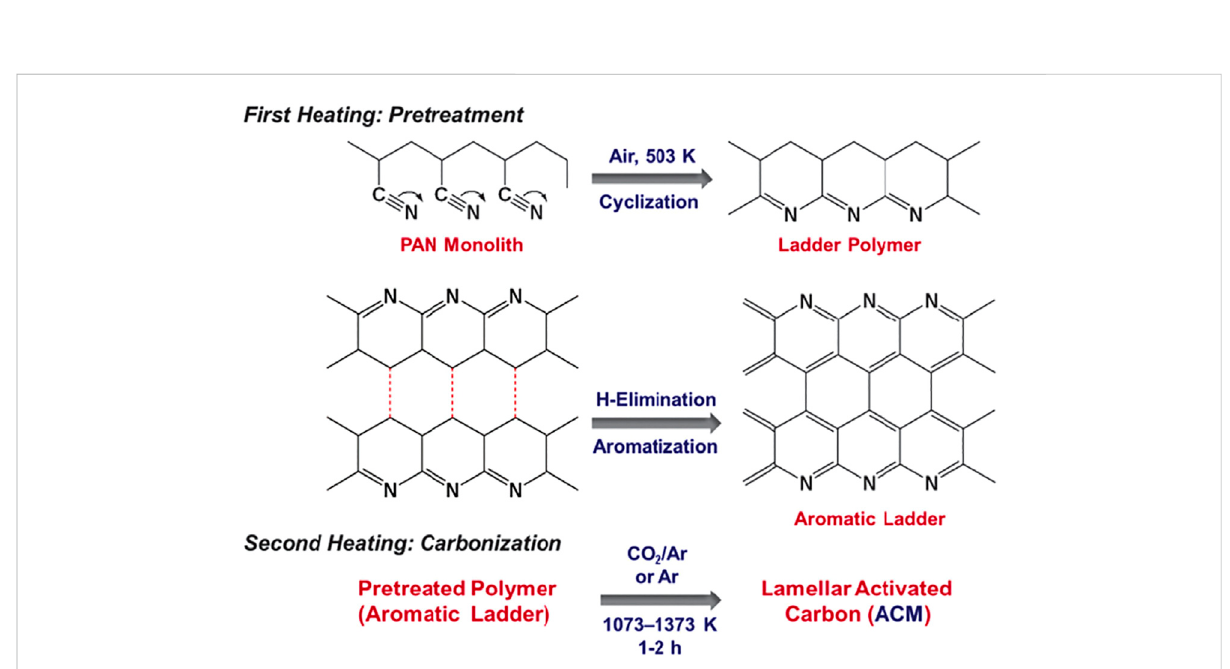
FIGURE 6 Carbonization of PAN monolith with CO 2 /air or air as activator (Nandi et al.,